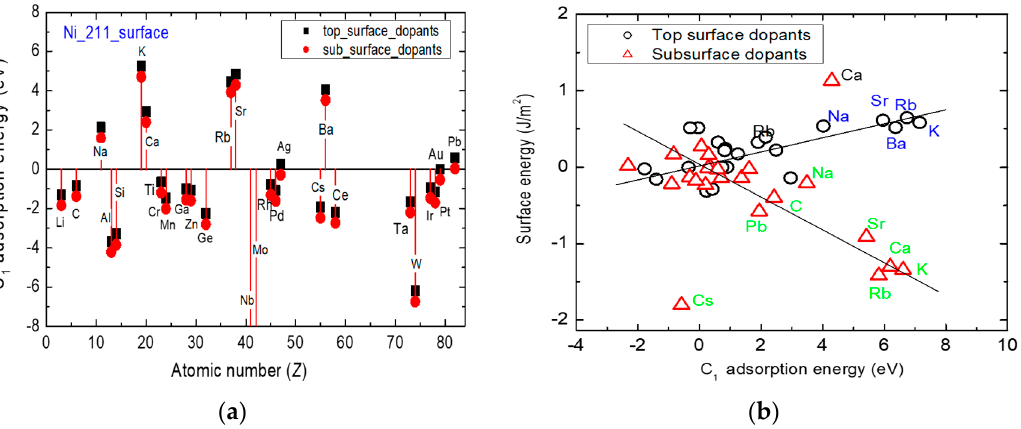
Figure 5. Disruptive effects of single-atom dopants on the free energy of the Ni(211) surface for top-surface (black squares) and sub-surface (red spheres) doping relative to the undoped surface. This figure shows the variation in the C 1 adsorption energy with the atomic number of the dopant ( a ) and the correlation between the dopant-induced change in the Ni(211) surface energy and the C 1 adsorption energy ( b ).